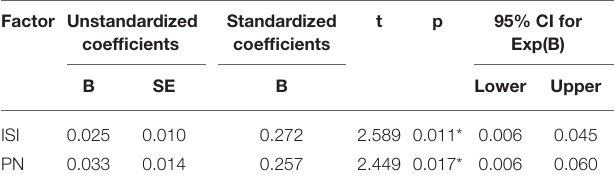
TABLE 4 | Results of the stepwise multiple linear regression: significant influencing factors for the severity of suicidal ideation in schizophrenic patients. Factor Unstandardized coefficients